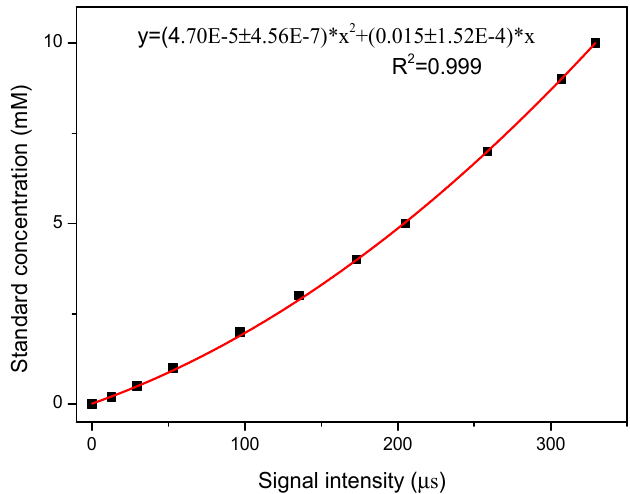
Figure 2. Correlation between signal intensity and standard solution concentration .